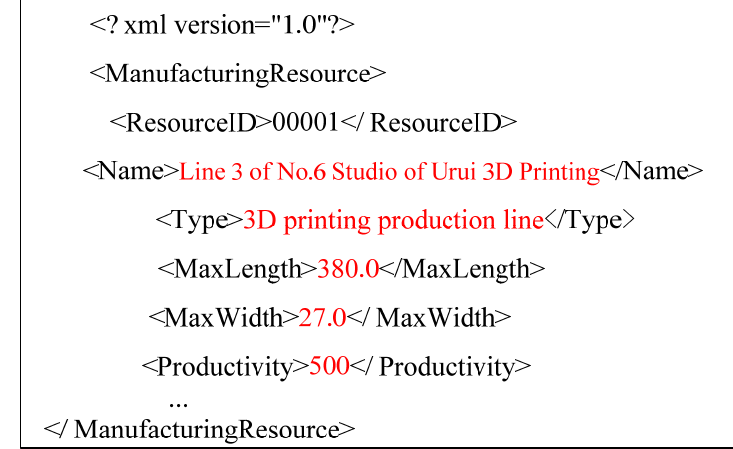
Figure 6. The Partial XML information graph of C3DPS template.